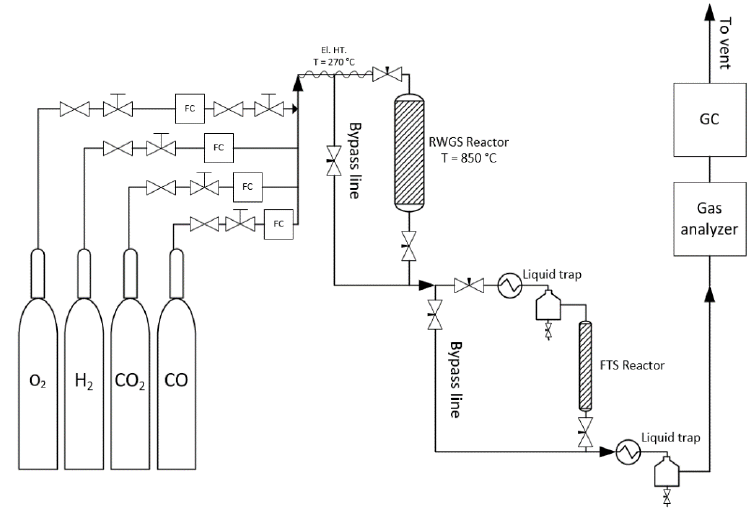
Figure 2. Schematic of the experimental